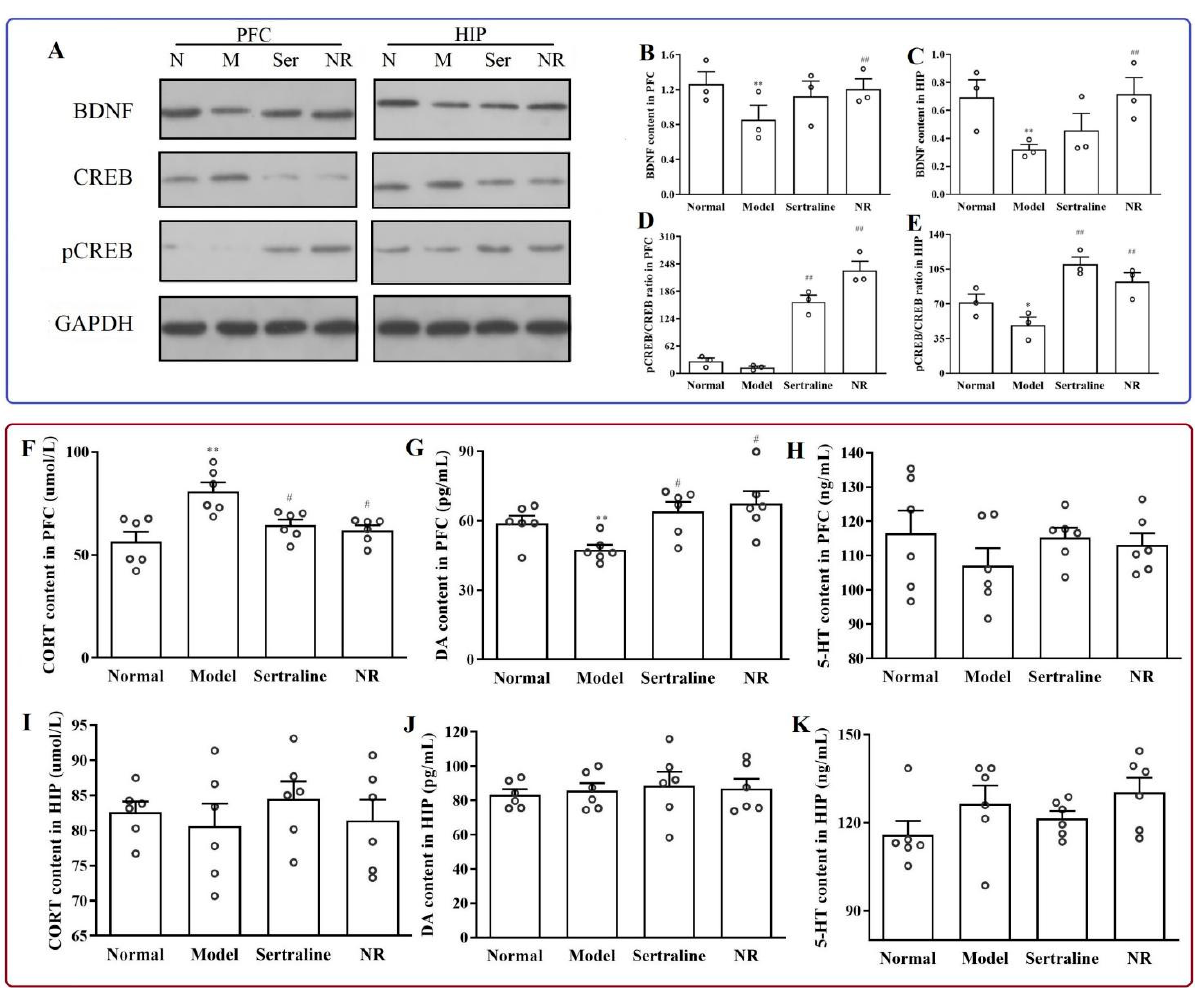
Figure 9. Levels of BDNF, pCREB/CREB, CORT, DA, and 5-HT in the PFC and HIP with NR treatment in CUMS-induced depression rats. ( A ) Levels of BDNF and TrkB in the PFC and HIP. ( B ) Levels of BDNF in the PFC. ( C ) BDNF levels in the HIP. ( D ) pCREB/CREB ratio in the PFC. ( E ) pCREB/CREB ratio in the HIP. (F) CORT level in the PFC. ( G ) DA level in the PFC. ( H ) 5-HT level in the PFC. ( I ) CORT content in the HIP. ( J ) DA content in the HIP. ( K ) 5-HT content in the HIP. * p < 0.05, ** p < 0.01 vs. normal group; # p < 0.05, ## p < 0.01 vs. model group. After CUMS, the CORT content increased (Figure 9F, F(3, 20) = 8.136, p = 0.001), and DA content decreased (Figure 9G, F(3, 20) = 5.803, p = 0.007) in the PFC. NR and sertraline reversed the CORT content (Figure 9F, F(3, 20) = 8.136, p = 0.010; Figure 9F, F(3, 20) = 8.136, p = 0.030, respectively) and DA content (Figure 9G, F(3, 20) = 8.136, p = 0.010; Figure 9G, F(3, 20) = 8.136, p = 0.040, respectively) in the PFC. However, there was no significant dif- ference in the CORT (Figure 9I, F(3, 20) = 0.412, p = 1.000) and DA (Figure 9J, F(3, 20) = 0.155, p = 1.000) content between the groups in the HIP. There were no differences in 5-HT levels among the groups in rats with CUMS-induced depression (Figure 9H, 8K). 4. Discussion We utilized Nampt flox/flox mice and long-term treatment with NR in rats with CUMS- induced depression and found that NAMPT-mediated NAD synthesis played a pivotal role in depression. They both led to significant changes in depression-like behaviors, lo- comotor activity, social behaviors, cognitive function, and social dominance positions. In addition,